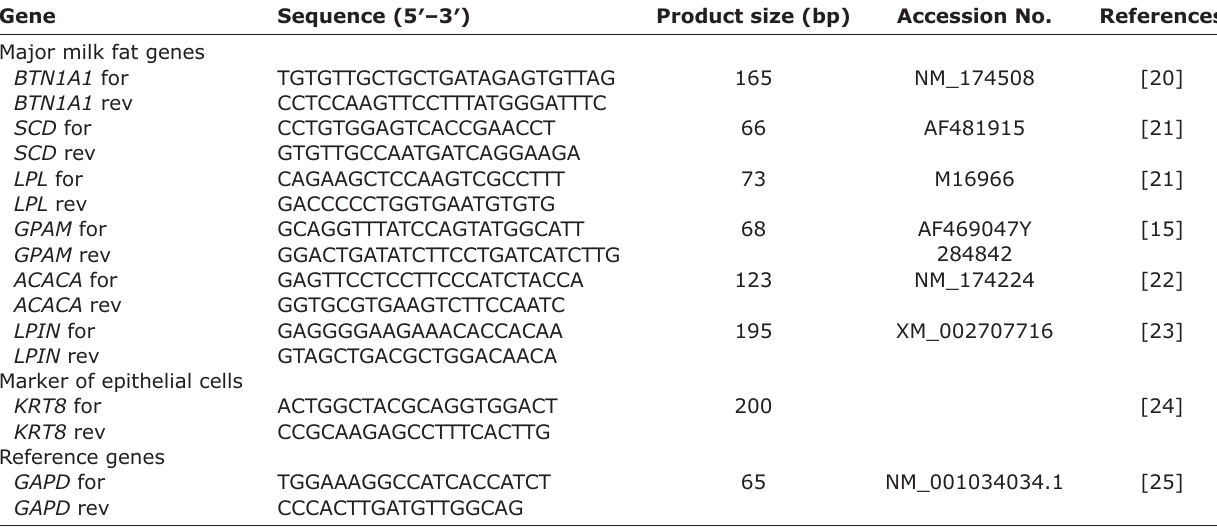
Table-2: Primer sequences for PCR amplification, product sizes, accession numbers and references for various genes under study.